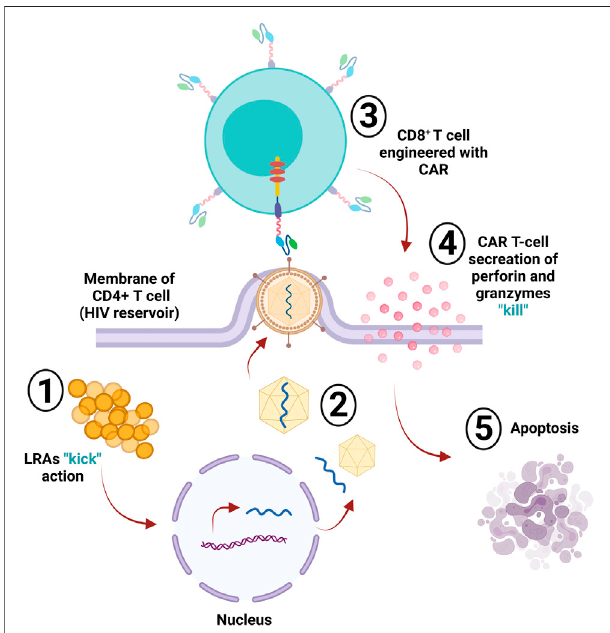
FIGURE 4 | HIV reservoir eradication. The “ kick and kill ” strategy is used to eliminate latently infected cells (reservoir); the “ kick ” part of this strategy depends on latency reversal agents (LRAs), which induce the virus via transcriptional reactivation of the incorporated provirus within the infected cell. The infected CD4 + T-cell then starts producing and assembling the virus. Upon leaving the cell membrane, the engineered CD8 + CAR T-cell will detect the expressed viral antigens; then, the “ kill ” action occurs via the secretion of perforin and granzymes, sending the cell into